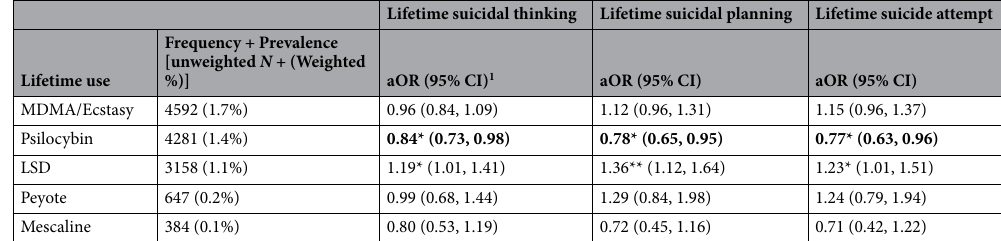
Table 2. Frequency and prevalence of lifetime MDMA/ecstasy and classic psychedelic use + results from survey-weighted multivariable logistic regression models examining the associations between MDMA/ ecstasy and classic psychedelics and lifetime suicidal thinking, planning, and attempt. All aforementioned demographic factors and substance use variables included as covariates 1 * p < 0.05; ** p < 0.01; *** p < 0.001; aOR adjusted odds ratio; CI confidence interval. Significant values indicating lowered odds of STBs are in